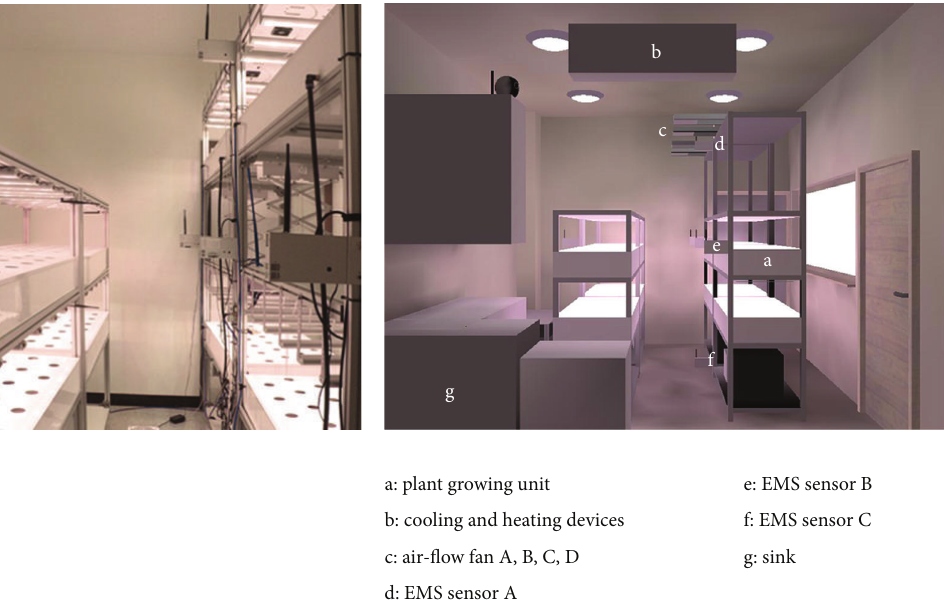
Figure 1: Experimental environment and facility.